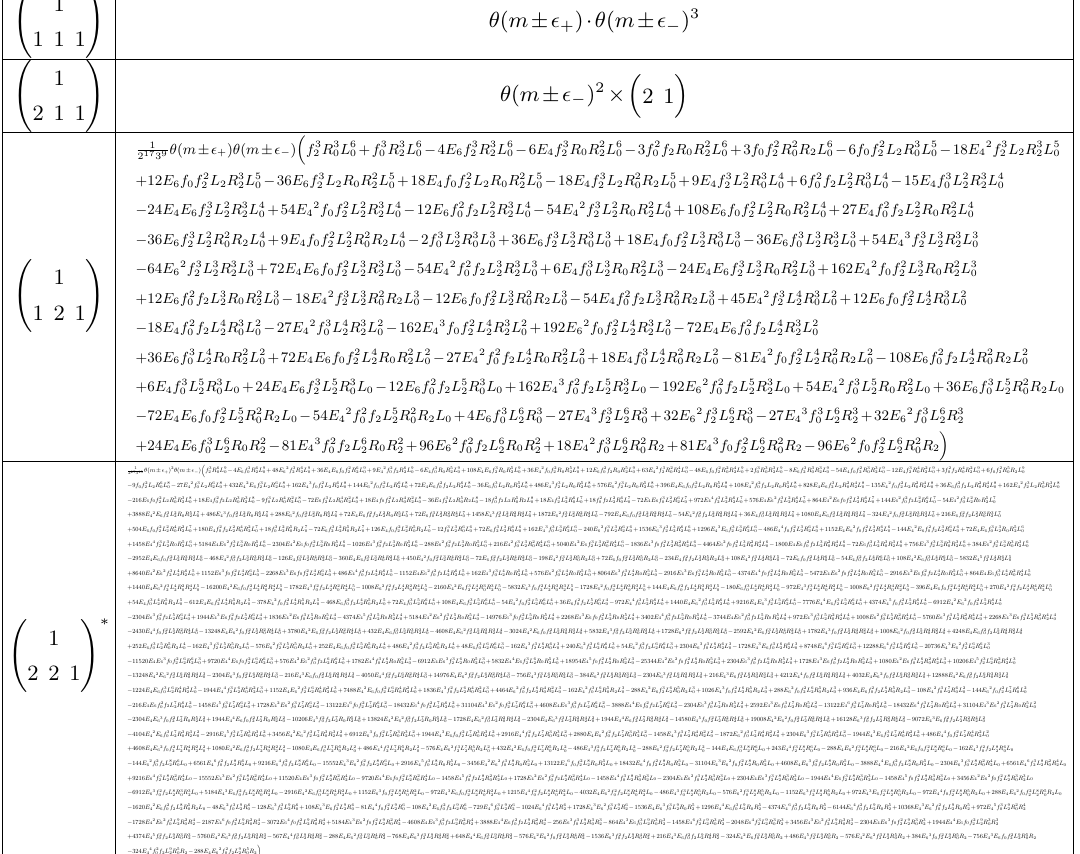
Table 4 . Elliptic genera of D 4 . The result that cannot be obtained from the flip symmetry is marked with the